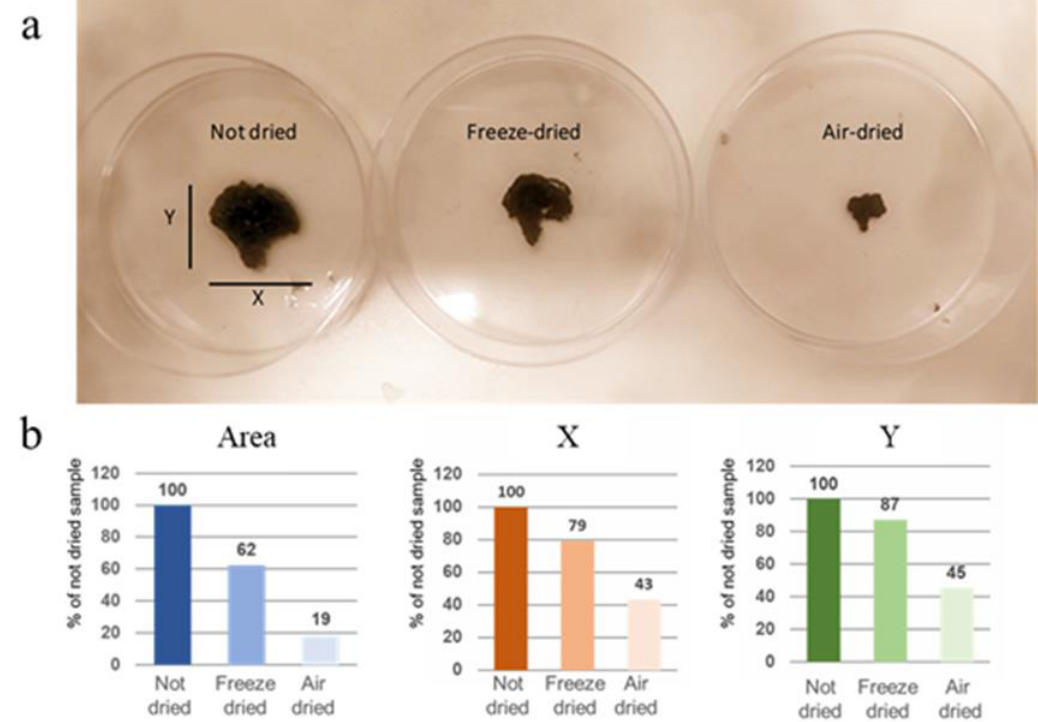
Figure 2. ( a ) Photo of not-dried scaffold compared to freeze-dried and air-dried samples. ( b ) Analysis of X, Y and Area measures, using ImageJ software. Values are % of not-dried sample.